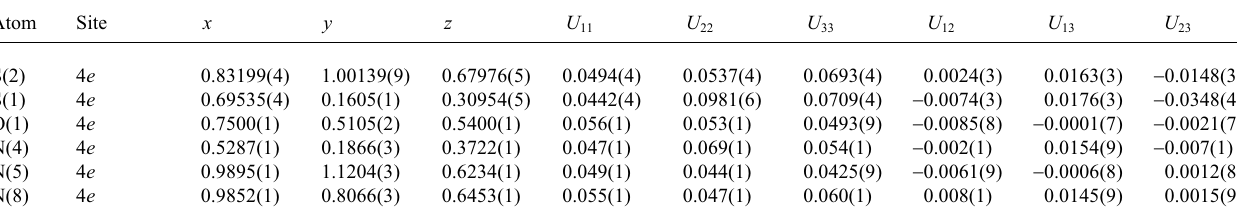
Table 3. Atomic coordinates and displacement parameters (in Å 2 )